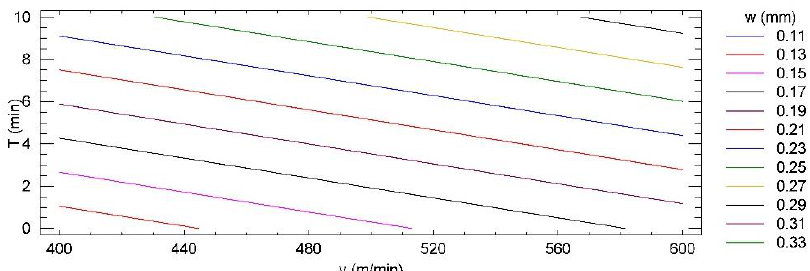
Figure 6. Contour plot for the relation between the input factors (machining time — cutting speed) and flank wear of CT5015 (ISO P15) insert.